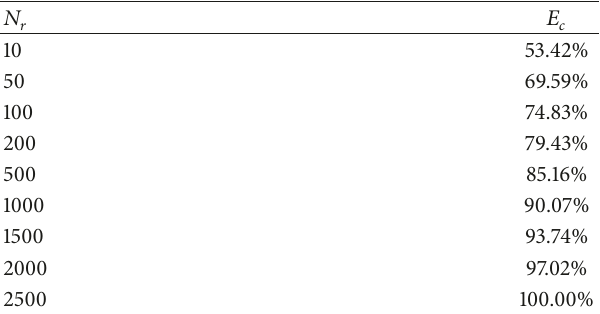
Table2:Therelationshipofenergycriterionandnumberofretained